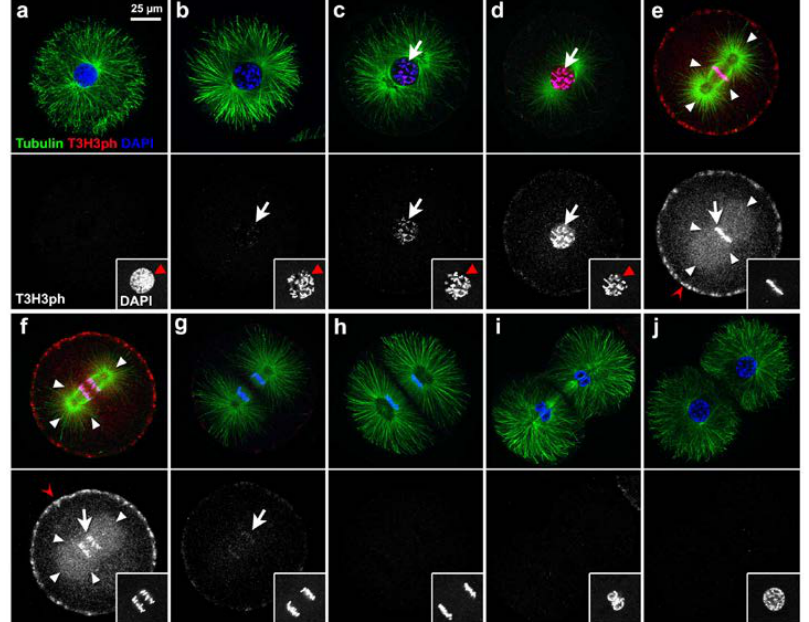
Figure 2. A wave of T3H3 phosphorylation / de-phosphorylation occurs in synchrony with mitotic division in S. granularis early embryos. ( a – j ) Pictures correspond to confocal equatorial optical sections obtained by imaging embryos immunostained for Tubulin (shown in green, top panels) and T3H3ph (red in the top panels, greyscale in bottom panels). Samples were also labelled with DAPI (blue in top panels, grey-scale in small insets). Images present consecutive stages illustrating progression through the first embryonic division. Scale bar, 25 µ m. ( a – d ) The T3H3ph signal (white arrows) appeared when chromatin condensation was already apparent in the cell nucleus (red arrowheads, insets). ( e , f ) A strong T3H3ph signal (white arrows) was observed in association with chromatin, both during the metaphase ( e ) and early anaphase ( f ). In these stages, a fluorescent signal associated with the cell cortex (red open arrowheads) and the mitotic spindle (white arrowheads) was also visible. ( g – h ) During the anaphase, the T3H3ph signal (white arrows) rapidly faded away. ( i , j ) No T3H3ph signal was detected during the